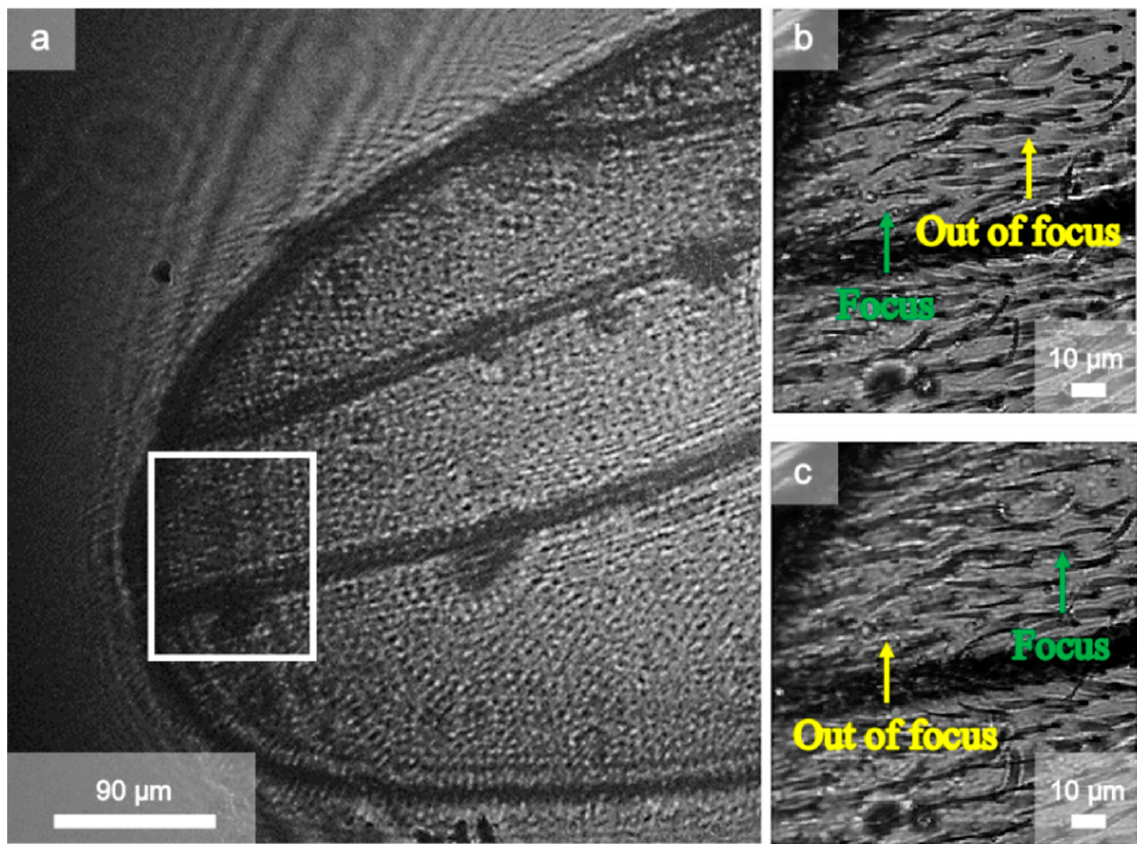
Figure 5. ( a ) Raw image in lensless mode of the fly wing sample. The refocusing images for the selected region of ( b , c ) corresponding to the height difference of 2 µm at 17 and 19 µm, respec- tively.